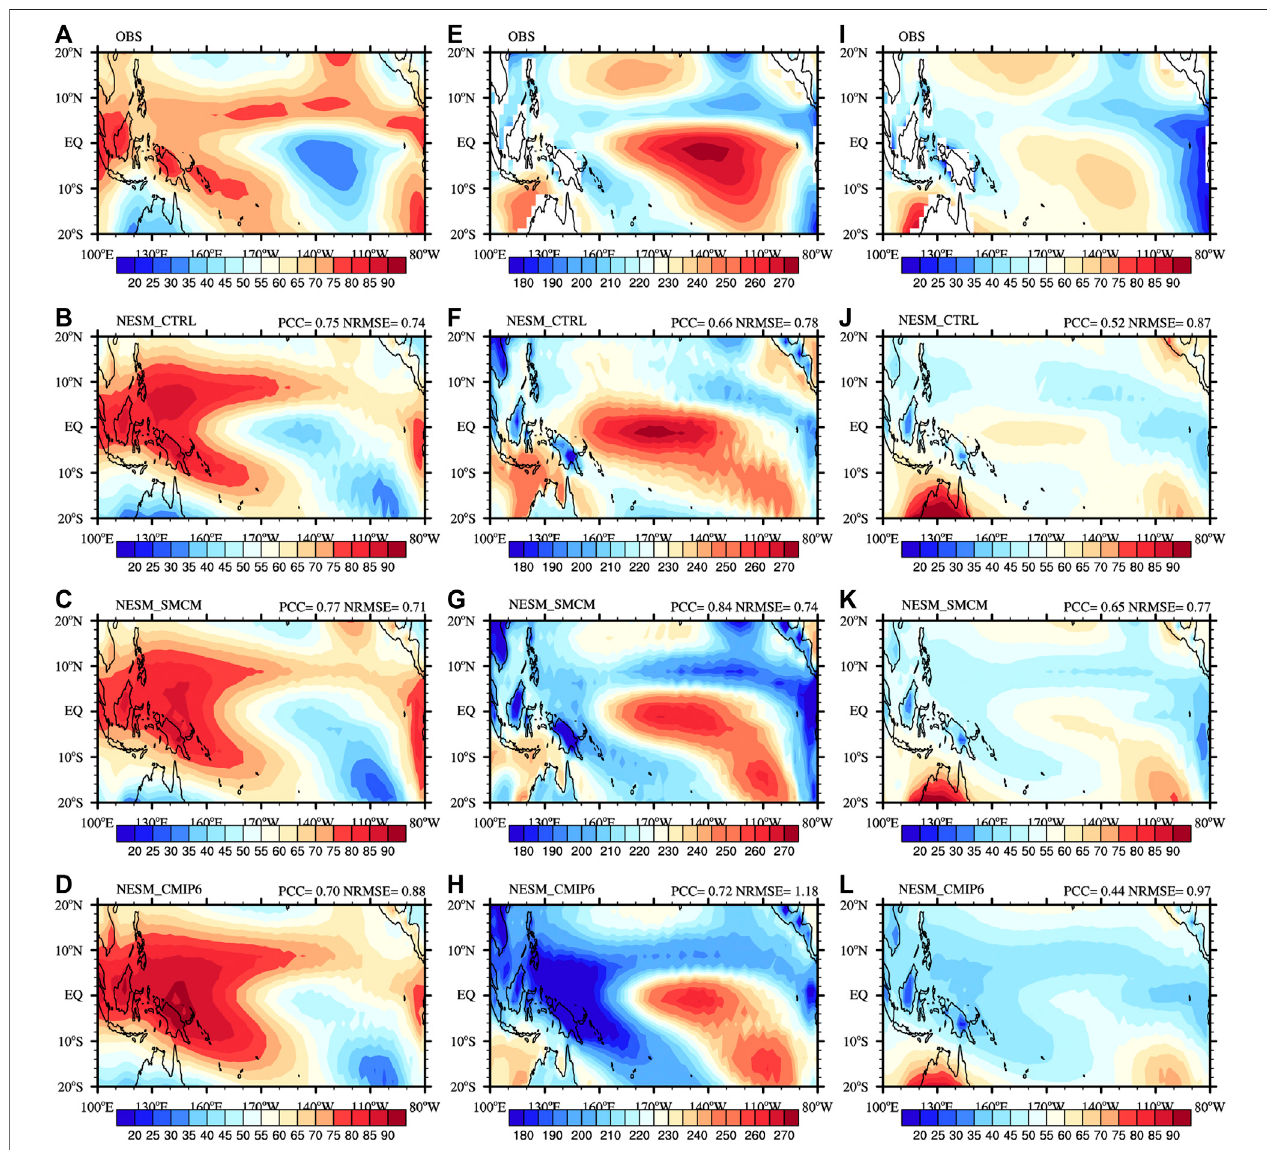
FIGURE 2 | Same as in Figure 1 except for the total cloud cover (left panel; in percentage), surface net shortwave radiation (middle panel; downward is positive; W m − 2 ), and surface net longwave radiation (right panel; upward is positive; W m − 2 ).